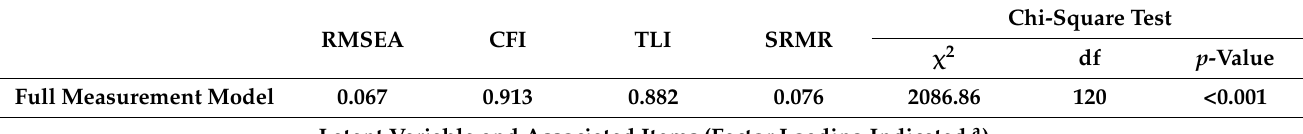
Table 2. Fit statistics for each latent variable and full measurement